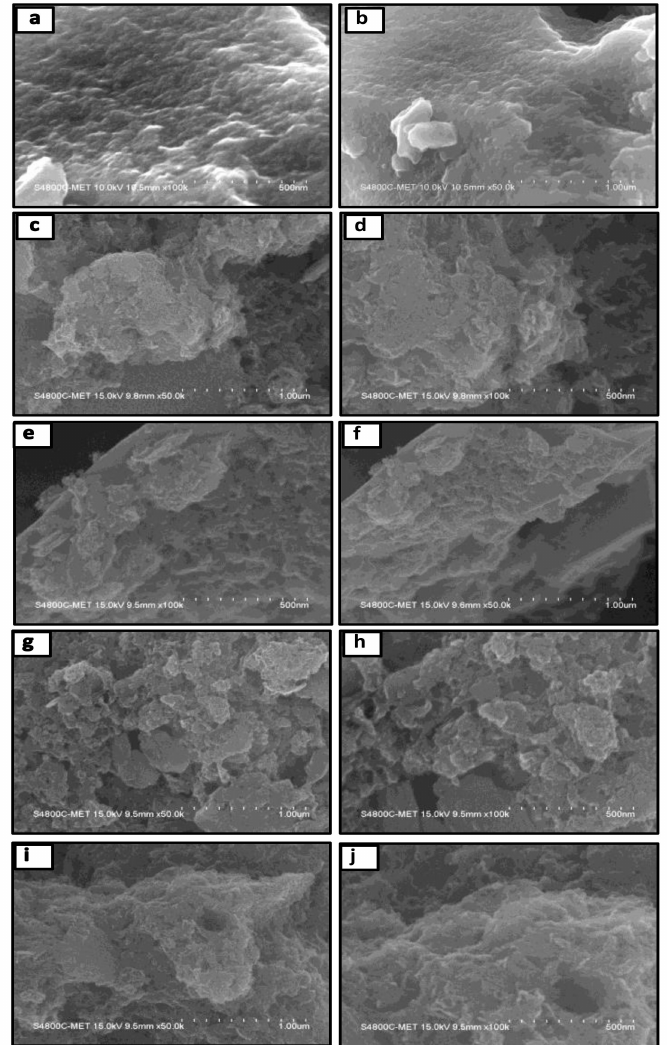
Figure 2. FESEM of ( a ) pure MoS 2 (MS-0), ( b ) MoS 2 -G, ( c , d ) MS-1, ( e , f ) MS-2, ( g , h ) MS-3, and ( i , j ) MS-4 at different